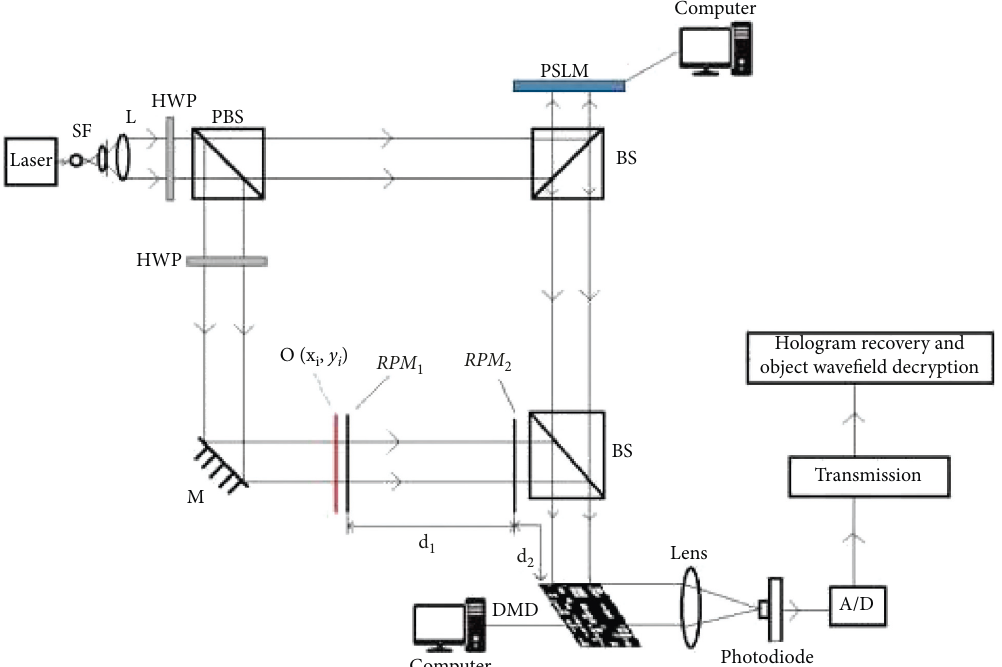
Figure 2: Schematic setup of PPSDH and single-pixel compressive imaging for encryption and decryption. SF: spatial filtering, L: col- limation lens, PBS: polarizing beam splitter, HWP: half wave plate, M: mirror, RPM: random phase mask, PSLM: phase-only spatial light modulator, BS: beam splitter, DMD: digital micromirror